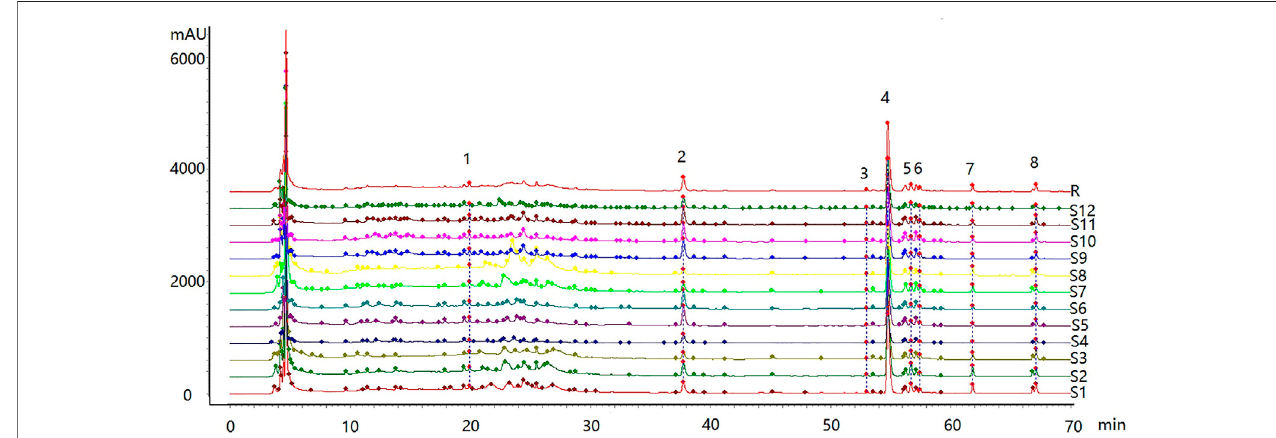
FIGURE 3 | Characteristic map of 12 batches of A. paniculata standard decoction.